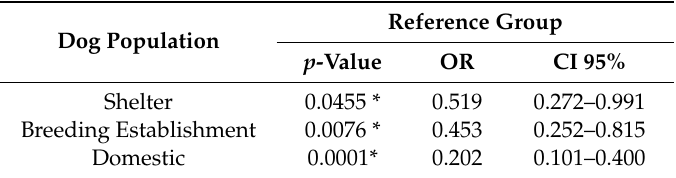
TableA5. Statisticalanalysisofassociationaspertypeofdogpopulation(shelter, breedingestablishment and domestic; stray dogs were considered as the reference